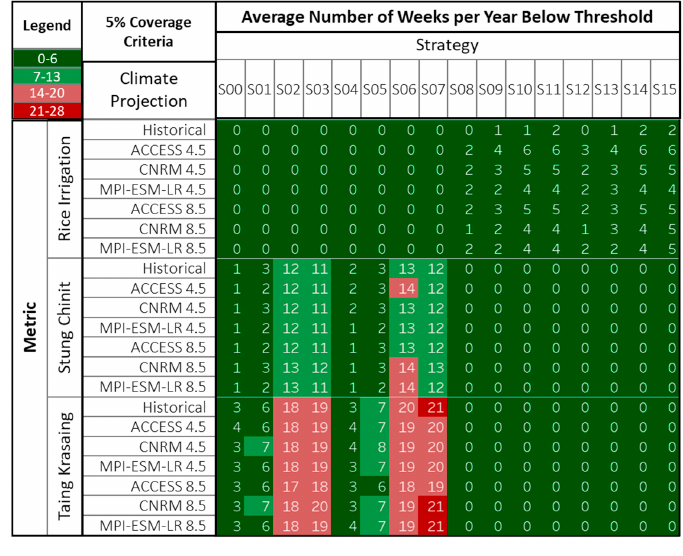
Figure 15. Average number of weeks per year where coverage is less than 5% coverage criteria.